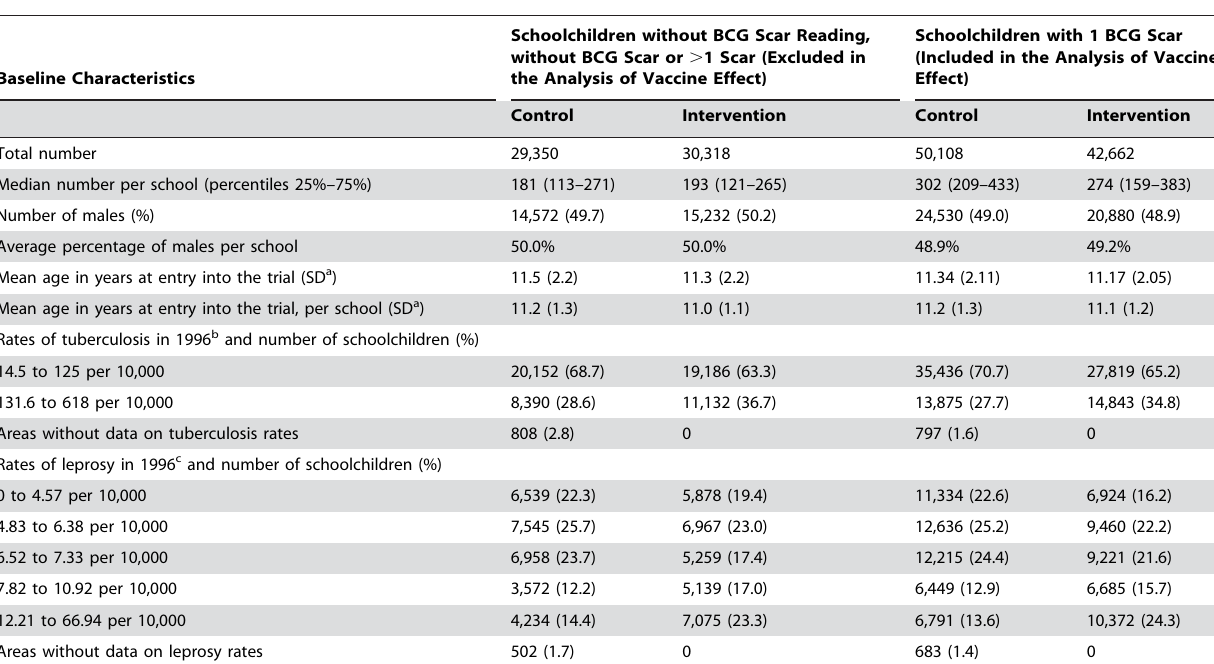
Table 1. Comparability of the baseline characteristics of the trial population, according to BCG scar.